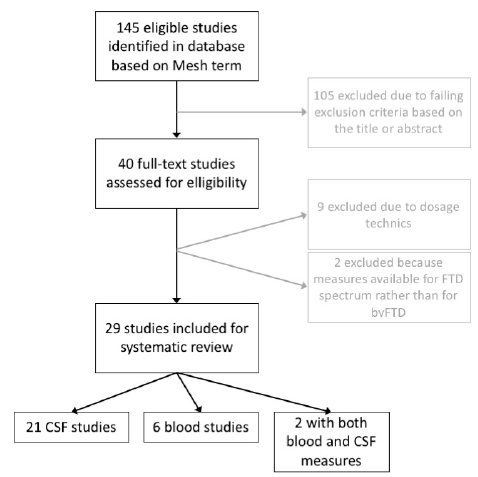
Figure 1. Flowchart of the selection process.